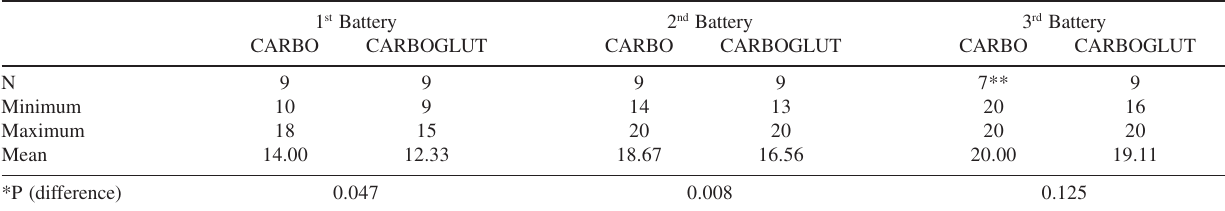
Table 2 – Perception of fatigue verified by the subjective Borg scale in three batteries of exercise in soccer players using carbohydrate (CARBO) and the mixture carbohydrate and peptide glutamine